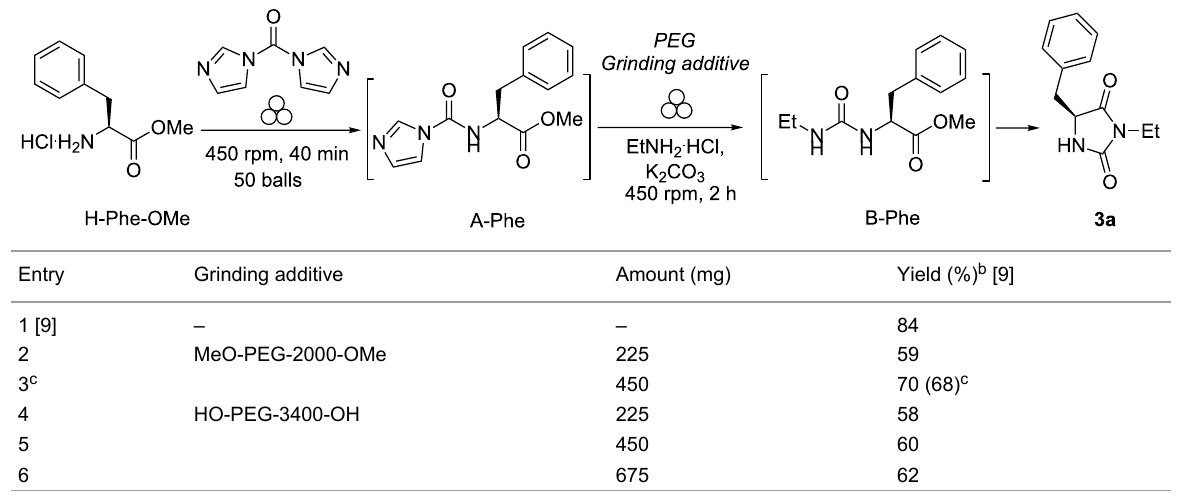
Entry Grinding additive Amount (mg)